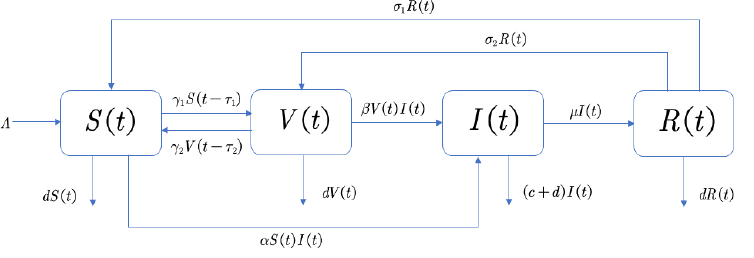
Figure 1. SVIR Model